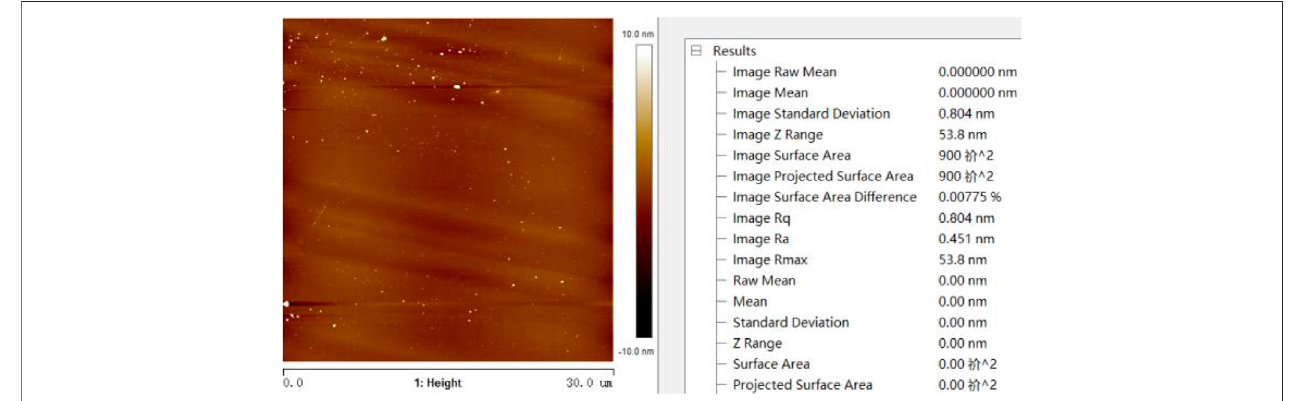
FIGURE 2 | (Color online) AFM image of Ga 2 O 3 /SiO 2 showing an RMS surface roughness of 0.54 nm within the area of 5 × 5 μ m 2 .